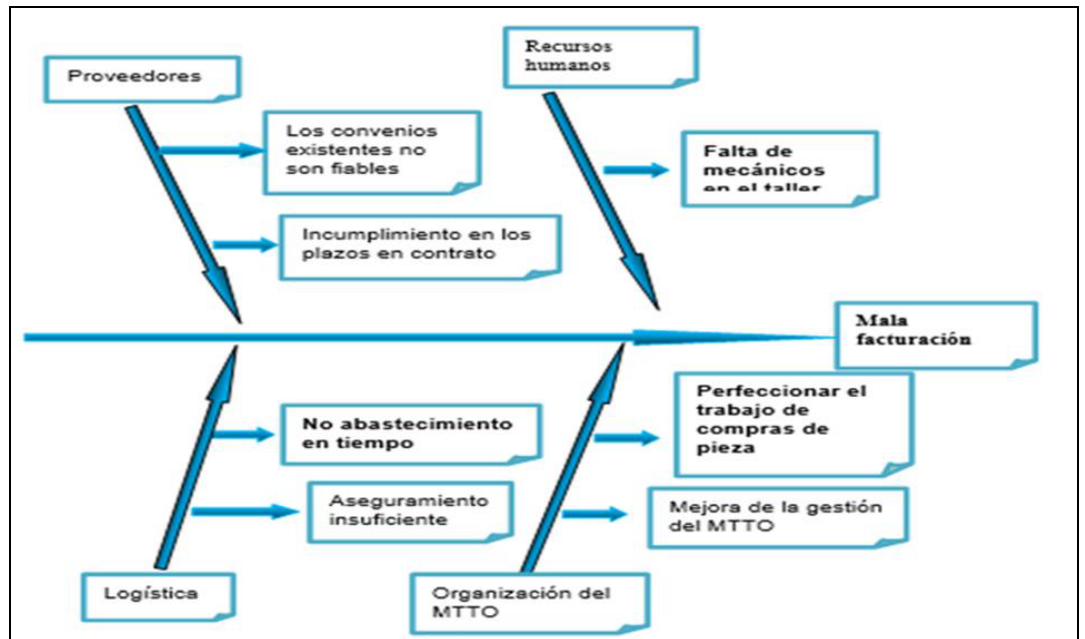
Figura 1: Resultado de la aplicación de método causa y efecto. Fuente: Los autores,